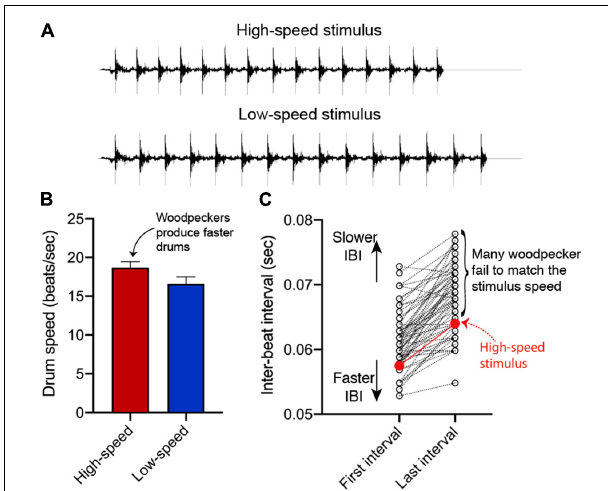
FIGURE 3 | Residents modulate the speed of their own drum displays to resemble that of the high-speed stimulus. (A) Representative waveform diagrams of high-speed and low-speed drum stimuli that were used during stimulated territorial intrusions (STIs). (B) In response to STIs with the high-speed stimulus, territorial residents produce significantly faster drums compared to those that heard the low-speed drum. Bars represent mean ± standard error (C) . Yet, many residents were not able to produce drums that were as fast as the high-speed drum stimulus. Residents on average produced drums that were approximately 4 ms slower than the actual high-speed stimulus. All data are reanalyzed from Schuppe and Fuxjager